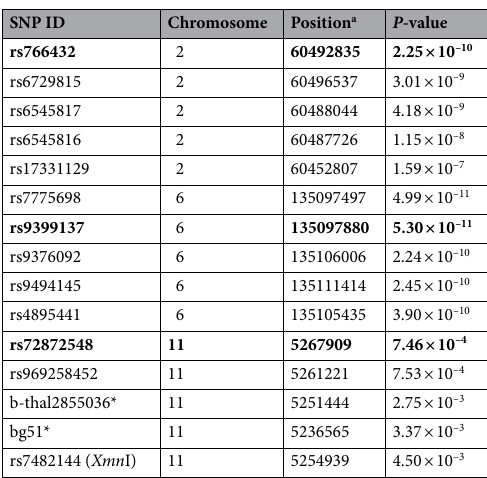
Table 2. Single SNPs analysis of the GWAS data by FaST linear mixed models for SNPs associated with disease severity in β 0 -thalassemia/HbE patients. The three predictive SNPs are indicated by bold letter. a Nucleotide positions for the SNPs are relative to the GenBank accession number GRCh38.p12 * = SNP not in NCBI database.